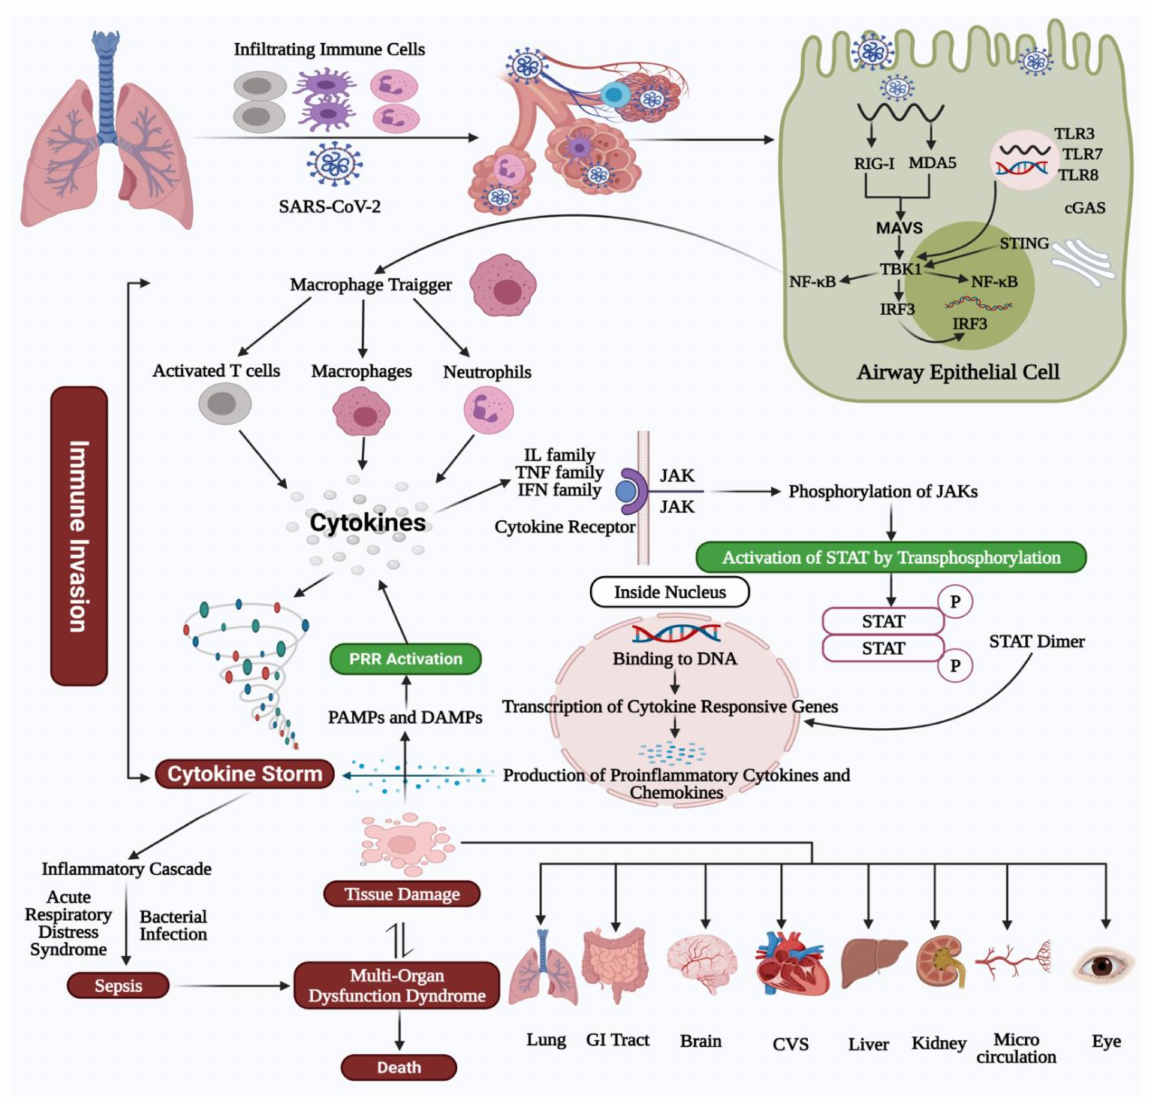
Figure 1. Molecular mechanisms, immune functions, and immunopathology of inflammatory cytokines in COVID-19. Overview of innate immune sensing annotated with the known means by which SARS-CoV-2. Following entry in the lung airway epithelial cell, the virus RNA genome may be recognized by pattern recognition receptors (PRR)s, including endosomal toll-like receptor (TLR)3, TLR7, TLR8 recognizing double-stranded and single-stranded RNA. The virus may be recognized in the cytosol by the retinoic acid-inducible receptor (RIG)-I or the melanoma differentiation-associated protein (MDA)5. Following viral recognition by PRRs, this triggers signaling through IFN regulatory factor (IRF)3 and NF- κ B to induce IFNs and pro-inflammatory cytokines. NF- κ B can also activate the macrophages, which contribute to increased cytokine levels and the cytokine storm. Cytokine binds to a specific receptor and allows transactivation of the associated Janus Kinases (JAKs). Activated JAKs then phosphorylate tyrosine on the receptor’s intracellular domains, which recruit the Signal Transducers and Activators of Transcription (STAT) transcription factors. STATs are translocated into the